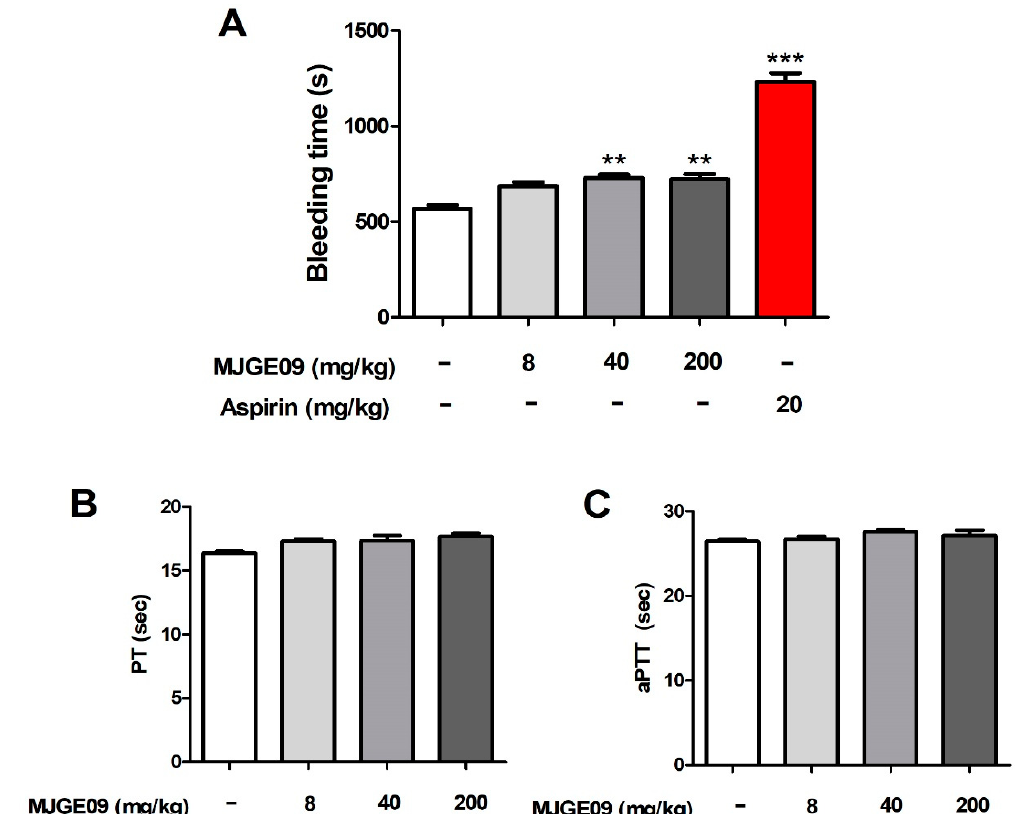
Figure 6. Effects of the MJGE09 extract on mouse tail bleeding times in vivo, and on the prothrombin time (PT) and activated partial thromboplastin time (aPTT) ex vivo. After the rats were orally administered the MJGE09 extract (8, 40, and 200 mg/kg), the tail tip was cut with a knife to measure the bleeding delay time ( A ). PT ( B ) and aPTT ( C ) were determined using a plasma coagulation analyzer. Data represent the mean ± S.E.M ( n = 6). Statistical significance was set at ** p < 0.01, and *** p < 0.001 when compared with the control group.